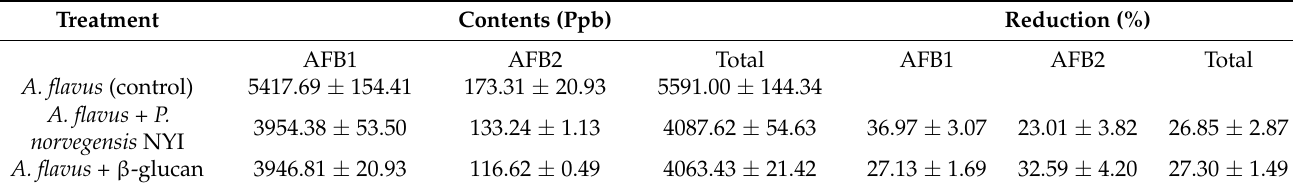
Table 3. Aflatoxin ‐ reducing activity of Pichia orvegensis NYI and its β‐ glucan.